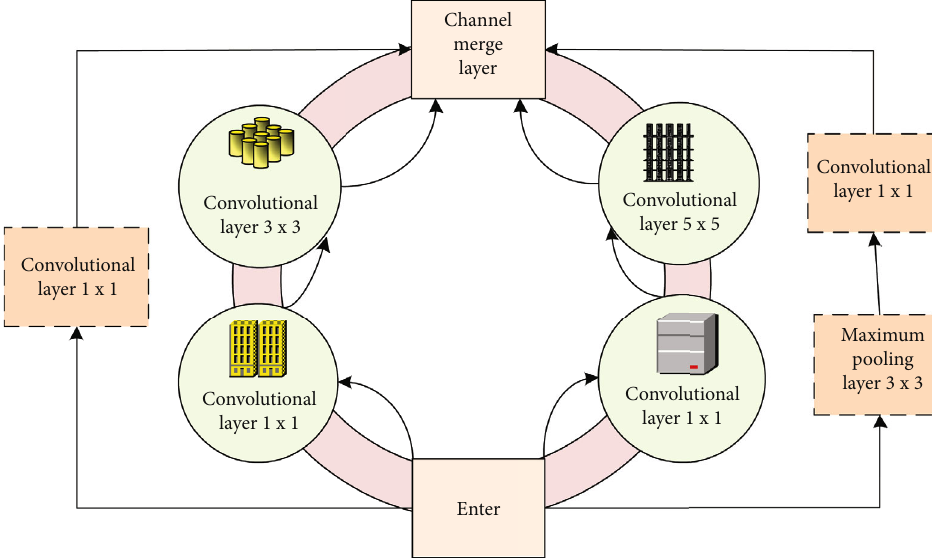
Figure 1: Basic convolution block under ROI-KNN convolutional neural network structure.